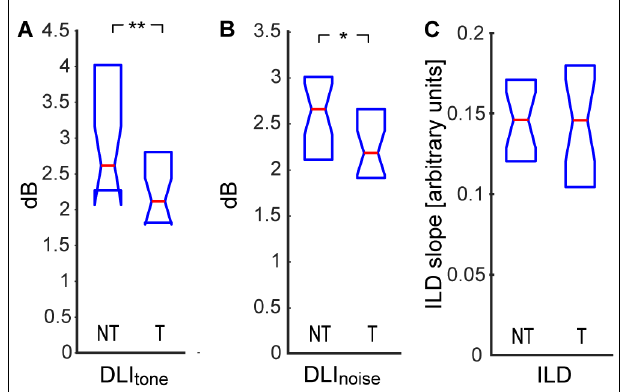
FIGURE 5 | Difference limen for intensity (DLI) of tone in noise (A) , DLI of noise (B) , sensitivity to interaural level difference (ILD; C ). Medians and IQR. Statistically significant difference denoted with asterisks (Wilcoxon rank-sum tests; ∗ p < 0.05; ∗∗ p <